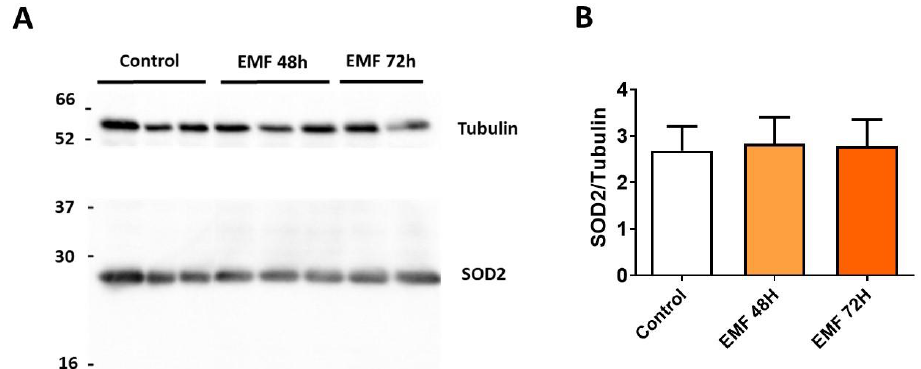
Figure 7. Myocardial expression of SOD2 in mice exposed to 915 MHz EMFs. Representative western blot image ( A ) and quantification ( B ) of SOD2 protein expression levels in mice exposed to 915 MHz EMFs for 48 h and 72 h and control animals The results present the mean ± SEM, n = 6 – 10.